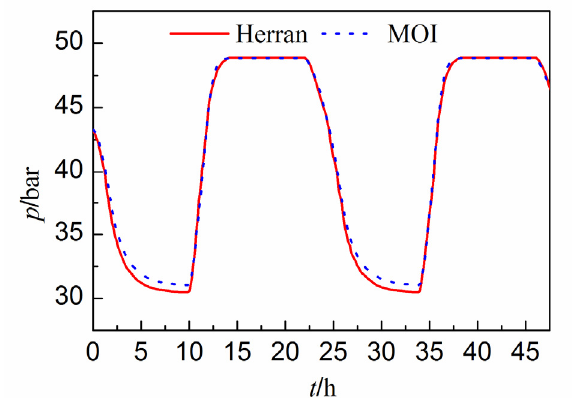
Figure 7. Pressure traces at the